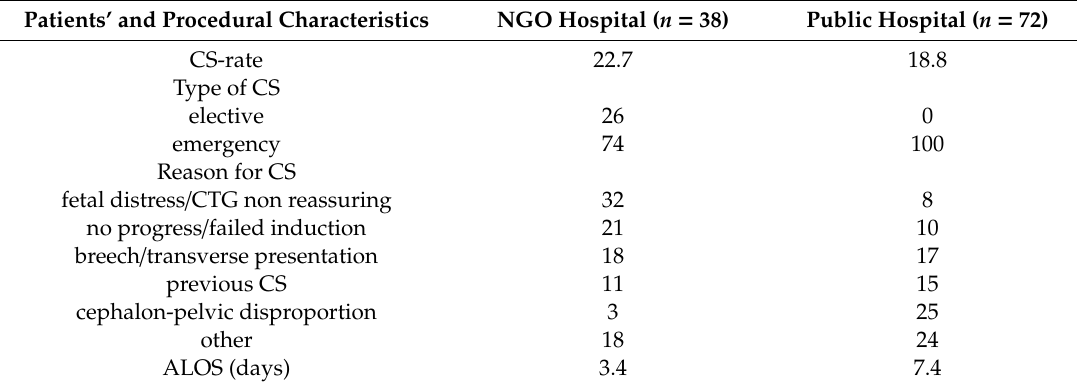
Table 3. Caesarian section characteristics (in